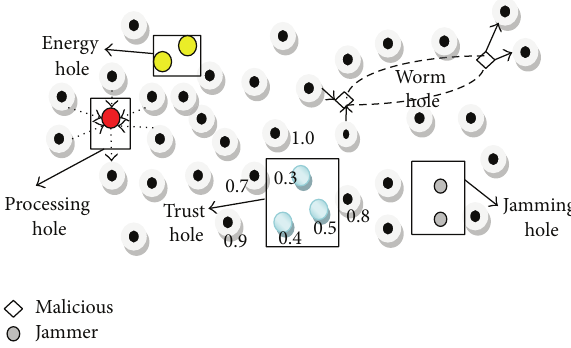
Figure 2: Types of holes.